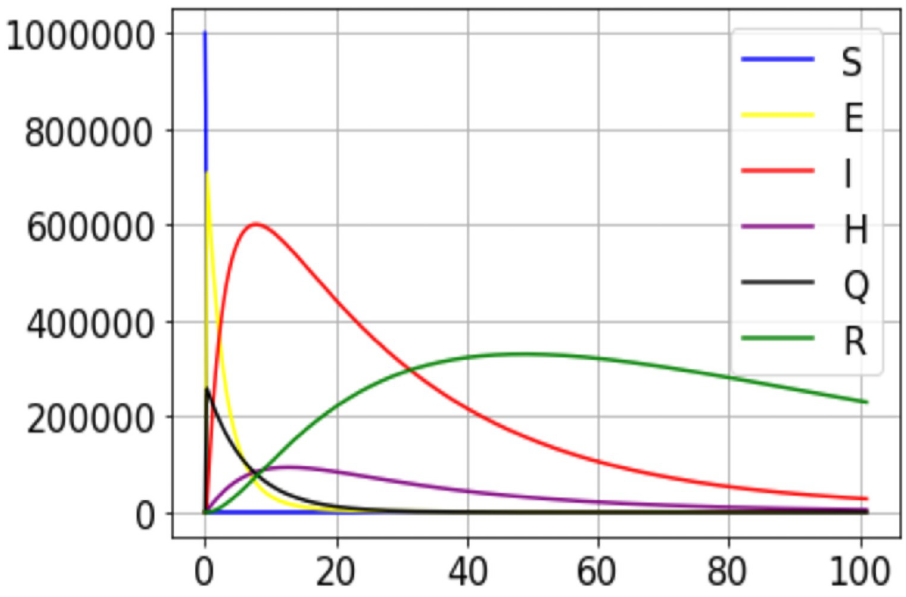
Fig 3. A simulation result for the outbreak using data from the 100 first days data from DRC ( � = 1.5).